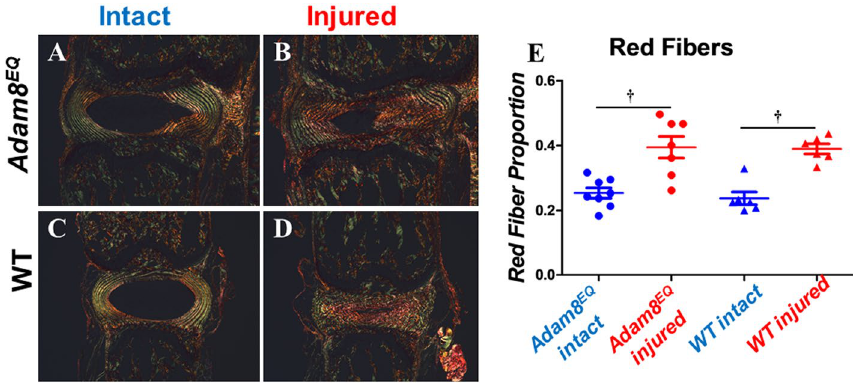
Figure 5. Red (thickest) fiber proportion increased in injured mouse intervertebral disc compared with intact controls in both Adam8 EQ and wild type (WT) mice. Left: injured and intact discs stained with picrosirius red (PSR) by polarized microscopy; right: red (thickest) fiber proportion; † p < 0.01.